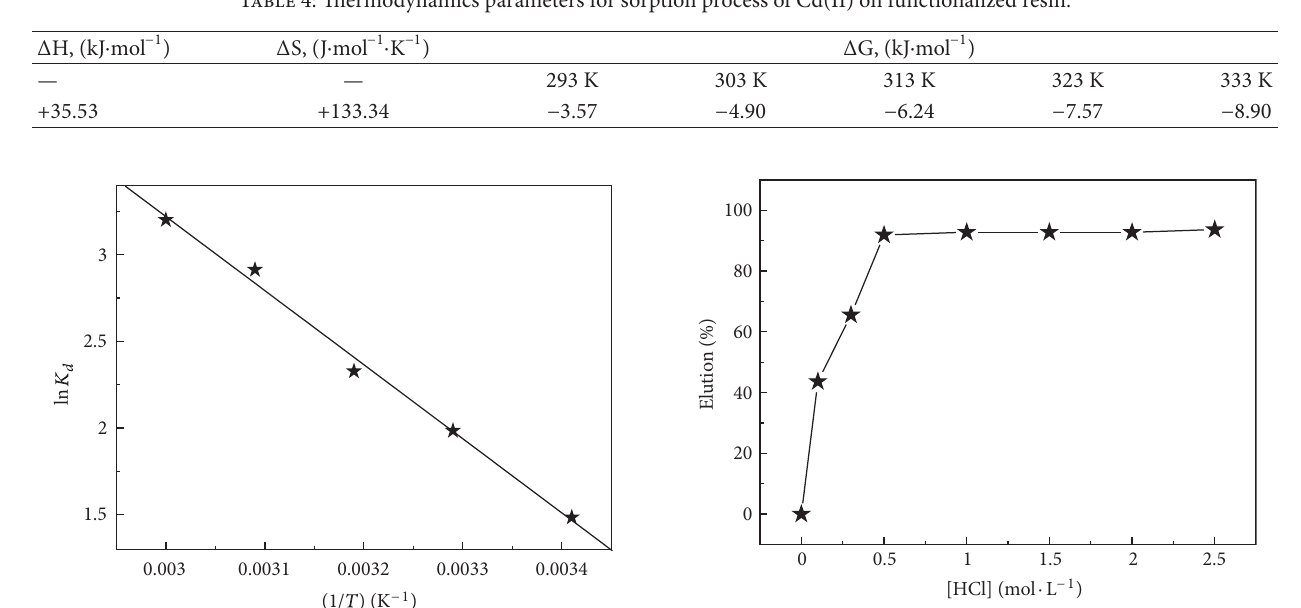
T 4: ermodynamics parameters for sorption process of Cd(II) on functionalized resin.